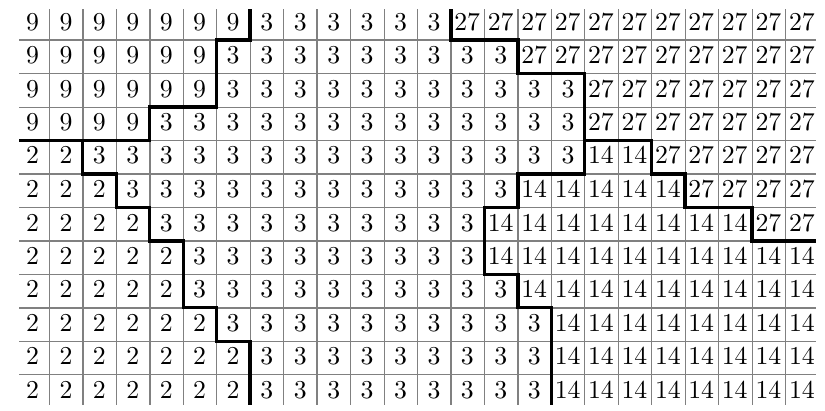
Figure 2. Illustration of a 2D grain structure mapped onto a square lattice. All lattice sites belonging to a common grain share the same lattice index s with thicker